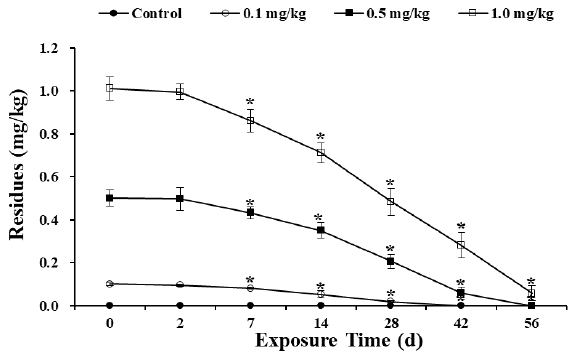
Figure 2. Residues of sulfoxaflor in artificial soil during the exposure period. Bars are the means ± SD of five replicates. Asterisks indicate the significant differences ( p < 0.05) between the exposure time.